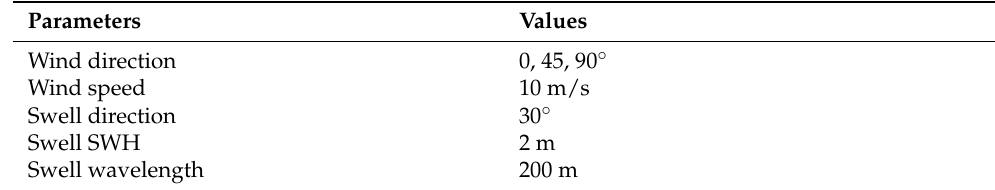
Table 5. The input parameters of ocean waves.